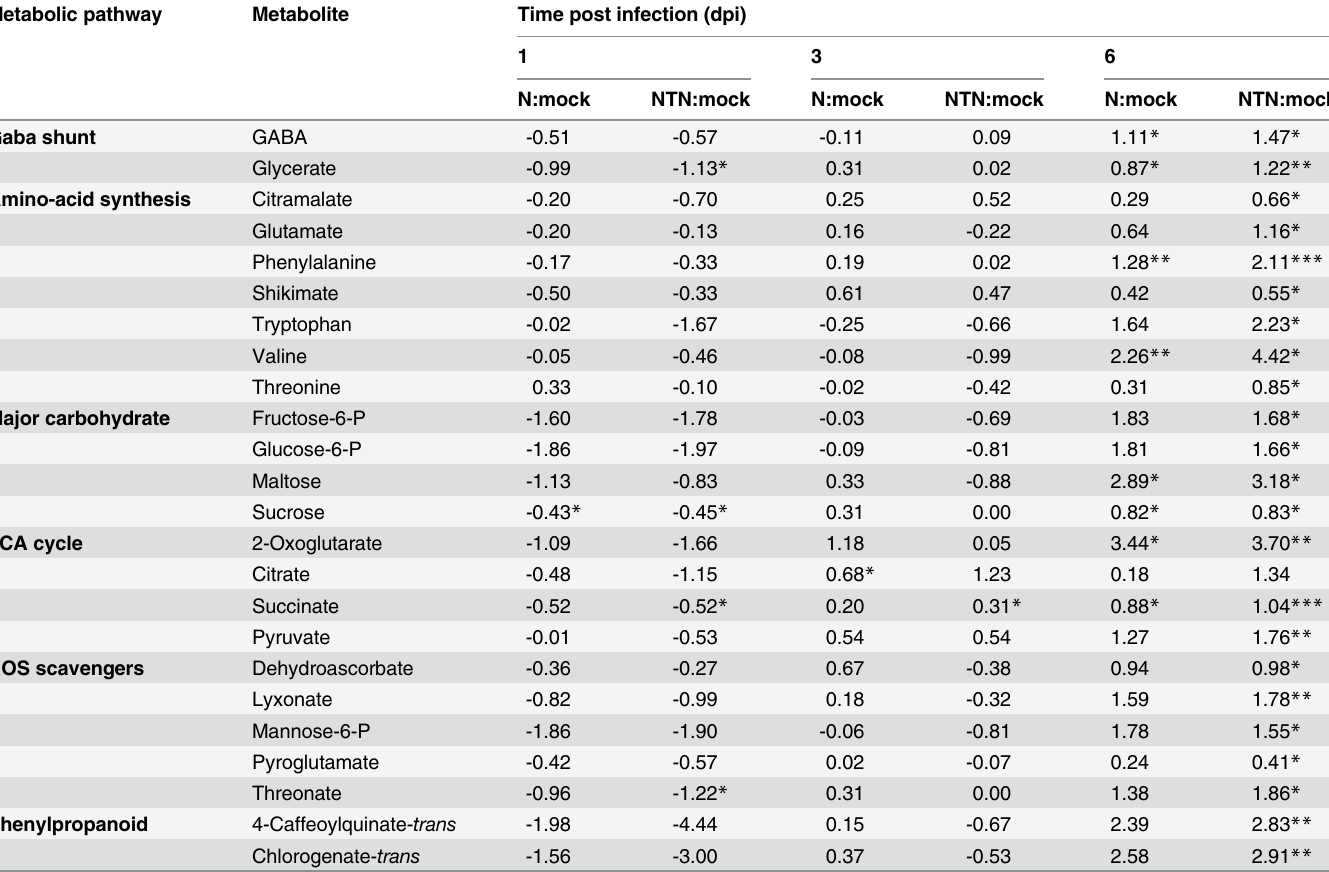
Table 1. Changes in the metabolite concentrations following mock inoculation and PVY inoculations. Metabolic pathway